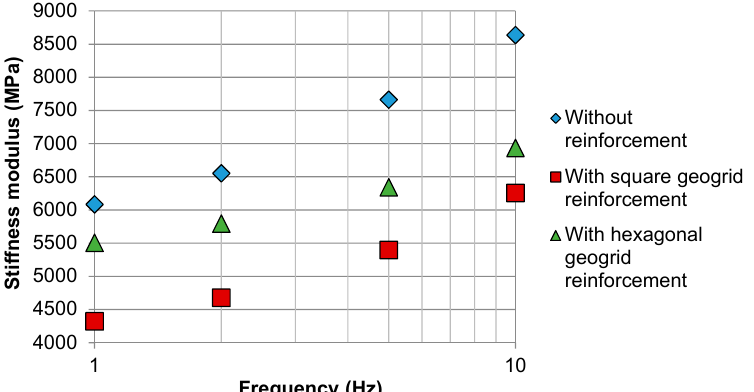
Figure 7. Shearing strength ( a ) and shearing stiffness ( b ) of systems without reinforcement, with hexagonal geogrid and with square aperture geogrid reinforcement.